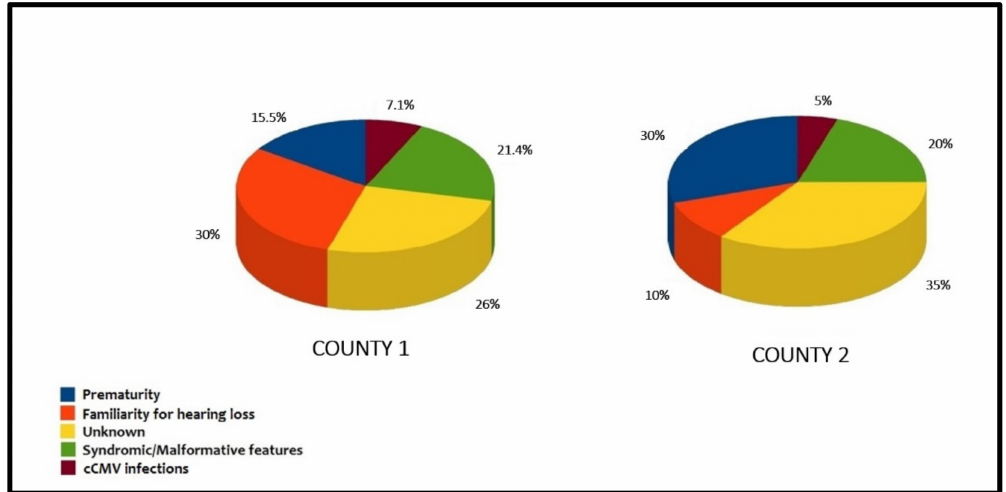
Figure 3. Audiological risk factors in the two examined